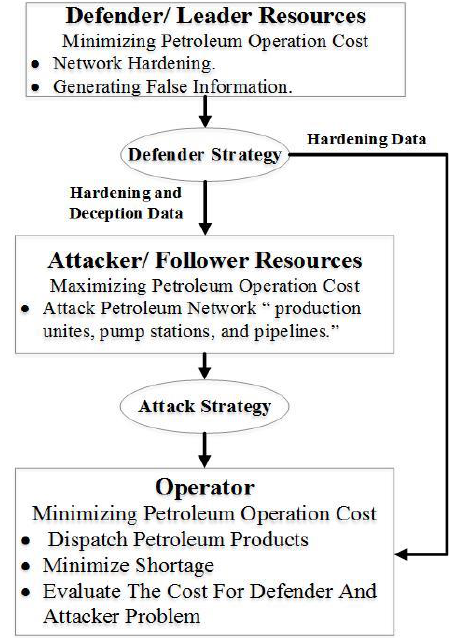
Figure 1. Tri-level model presentation; with defender, attacker, and operator interactions.